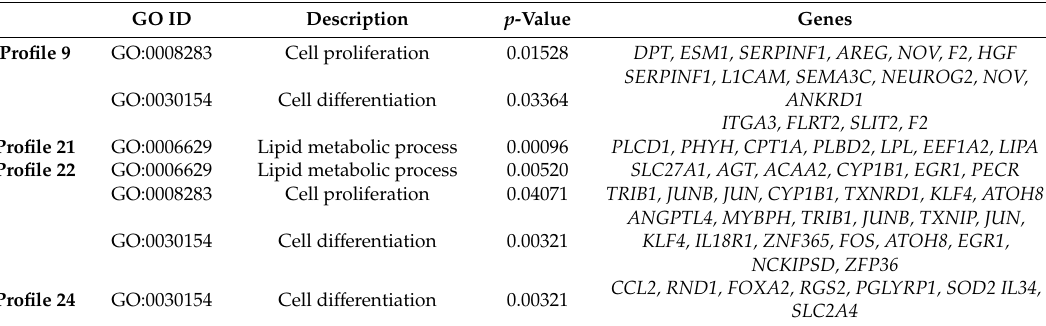
Table 5. Summary of Gene Ontology analysis of DEG clusters.